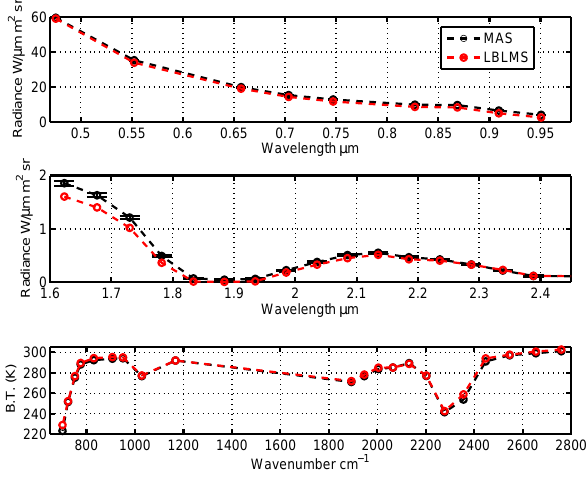
Fig. 4. Comparison of LBLMS simulations and MAS observations at nadir in clear sky conditions. Top and mid panel: comparison of upwelling radiance at 20km; lower panel: IR brightness tempera- ture.